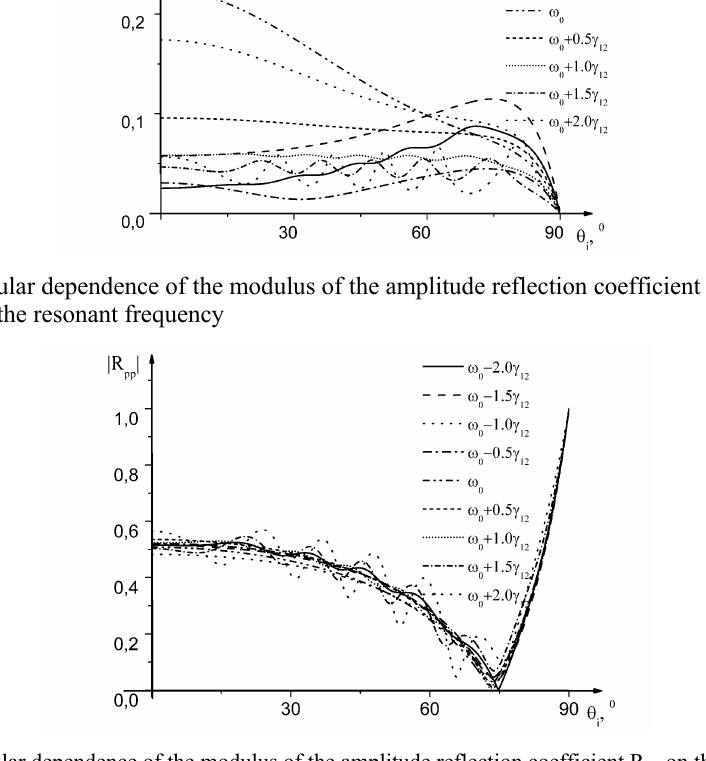
Fig. 5 . Angular dependence of the modulus of the amplitude reflection coefficient R pp on the angle of incidence in the vicinity of the resonant